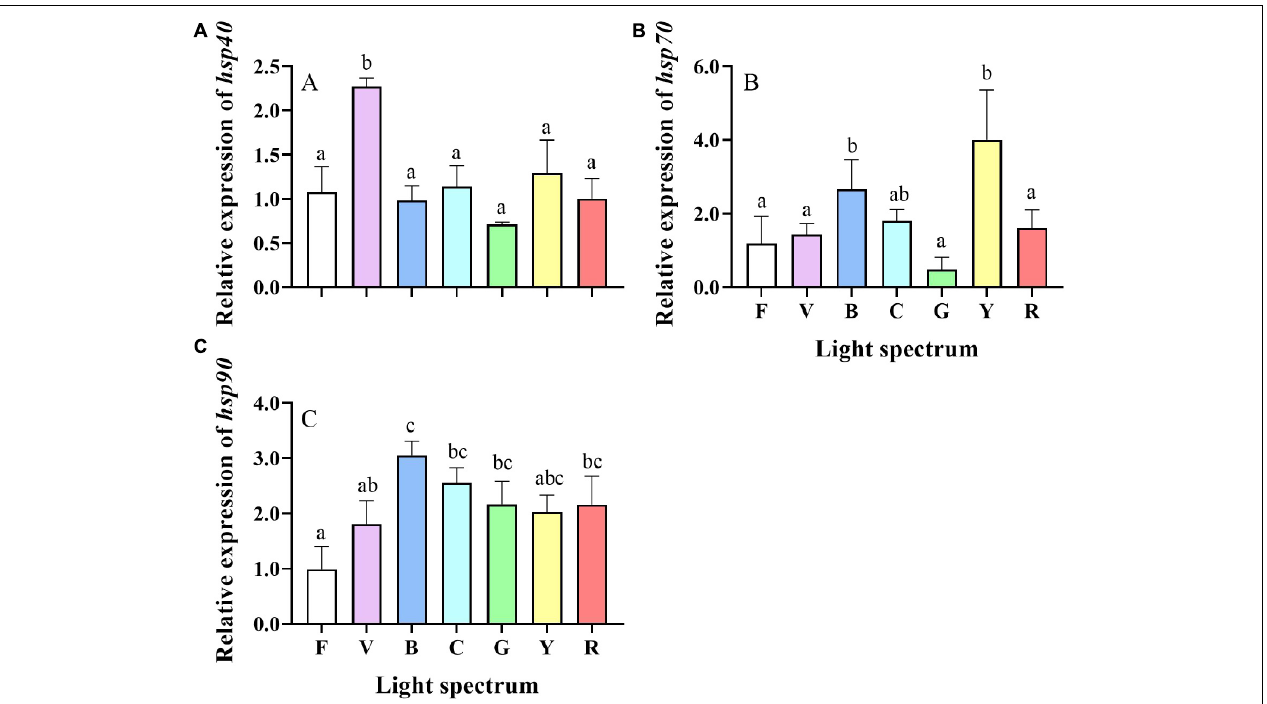
FIGURE 8 | Gene expression of heat shock protein 40, 70, and 90 [ hsp40 (A) , hsp70 (B) , and hsp90 (C) ] in the hepatopancreas of S. paramamosain reared under the various light spectrum. Values are expressed as means ± SD ( n = 3, 2 individuals per replicate). F, Full spectrum; V, Violet; B, Blue; C, Cyan; G, Green; Y, Yellow; R, Red. Different superscripts denote significant differences between treatments ( P <